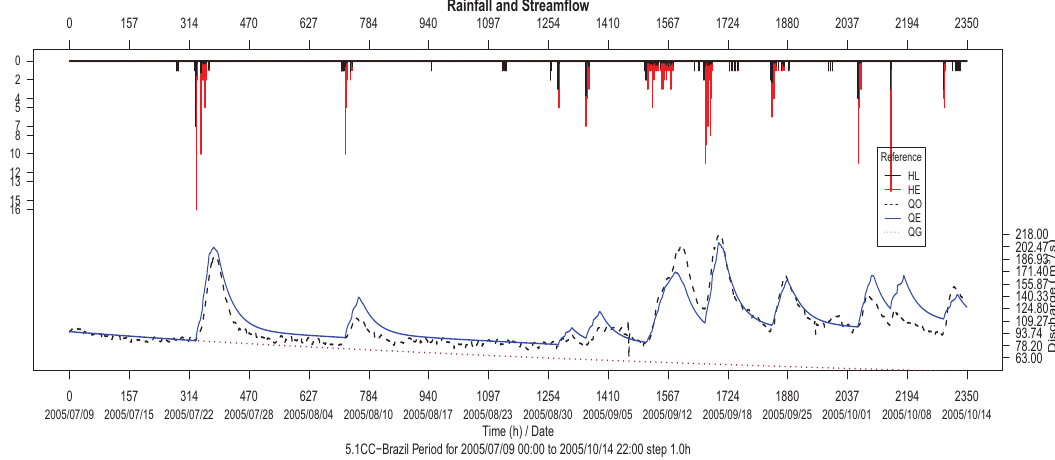
Figure 16. Hyetograph and Hydrograph from validation data series 5.1CC of Juquiá river at